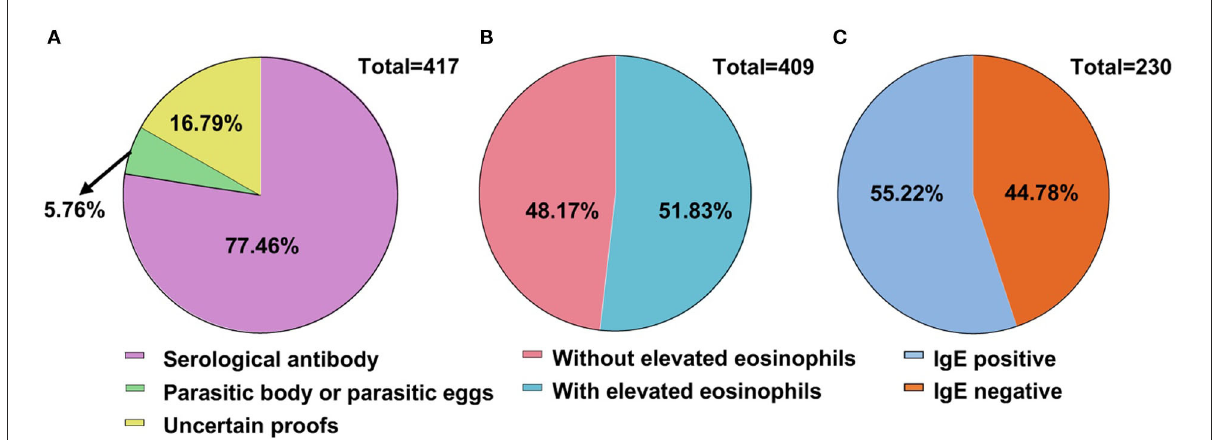
FIGURE5 Evidence of parasitic infection for diagnosis. (A) Evidence of parasitic infection for diagnosis. Definite evidence of diagnosis had been found in 343 cases, accounting for 83.22%. (B) Eosinophilia and parasitic infection. Two hundred and twelve (51.83%) among the total patients were detected with elevated eosinophil count. (C) Immunoglobulin E (IgE) and parasitic infections. IgE detection was conducted in 230 patients with more than half (55.22%) showing positive parasitic antibodies (127 cases).